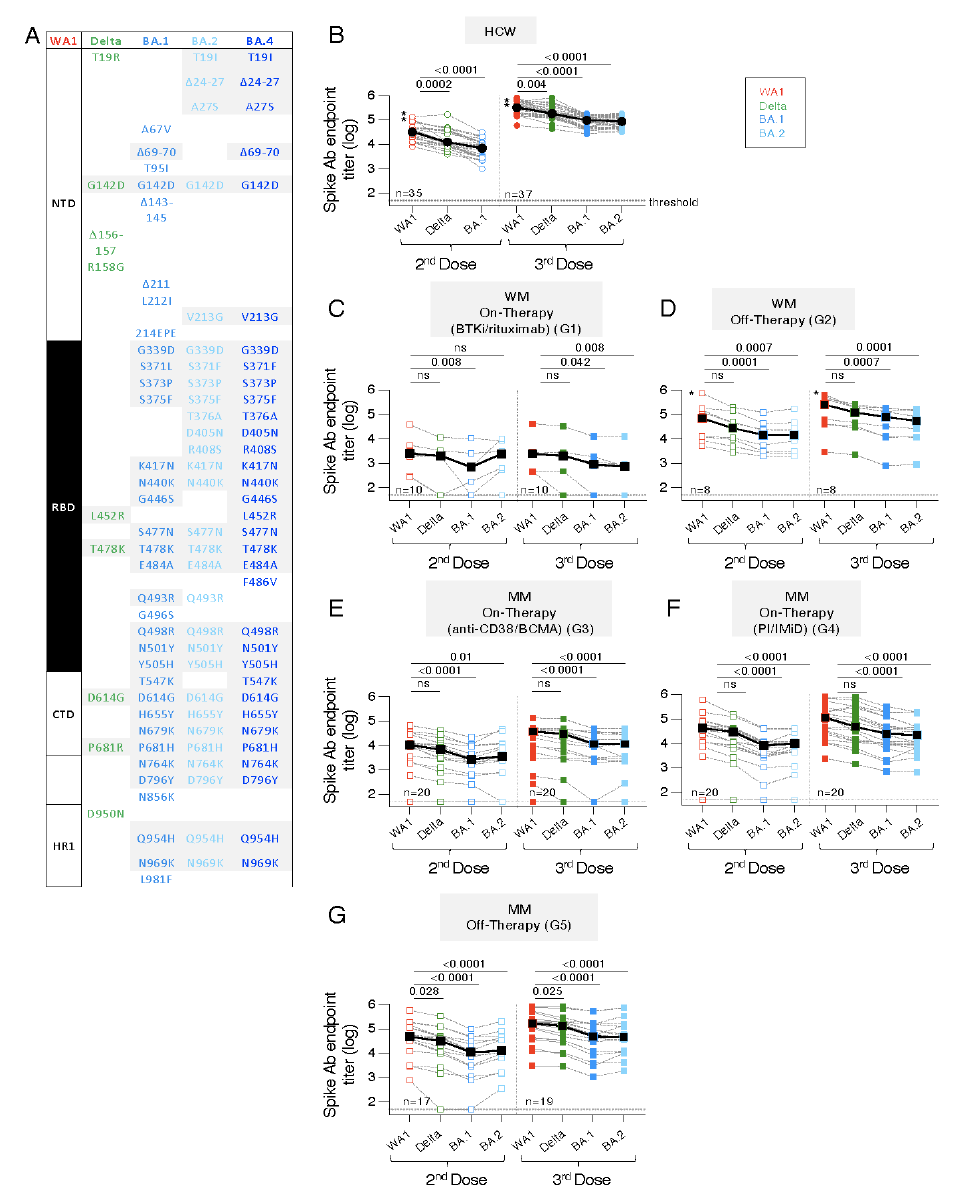
Figure 3. Breadth of anti-Spike antibody responses in patient cohorts and control BNT162b2 mRNA vaccine recipients. ( A ) Cartoon depicting AA changes comparing the original WA1 Spike proteins to a panel of Variants of Concern (VOC) including Delta (9 positions), Omicron variants BA.1 (34 positions), BA.2 (29 positions) and BA.4/5 (33 positions). Grey shading denotes shared changes. The following Spike regions are denoted: Spike S1 comprising NTD, N-terminal domain; RBD, Receptor Binding Domain; and CTD, C-terminal domain; and the Spike S2 with the Heptad Region 1 (HR1). ( B – G) Comparisons of anti-Spike antibody responses to WA1 and Delta, Omicron BA.1 and BA.2, performed at one month after the 2nd (D50) and 3rd dose (M10) in ( B ) HCW and the different ( C , D ) WM and ( E – G ) MM patient cohorts. Median values are given in black symbols and black lines. A titer at the threshold of detection is entered as 50 (log 1.6). Asterisks denotes WM patient and HCW with SARS-CoV-2 infection before study entry. The p values are from ANOVA (Friedman test) for the comparisons to the WA1 NAb responses. ns – no significant difference.